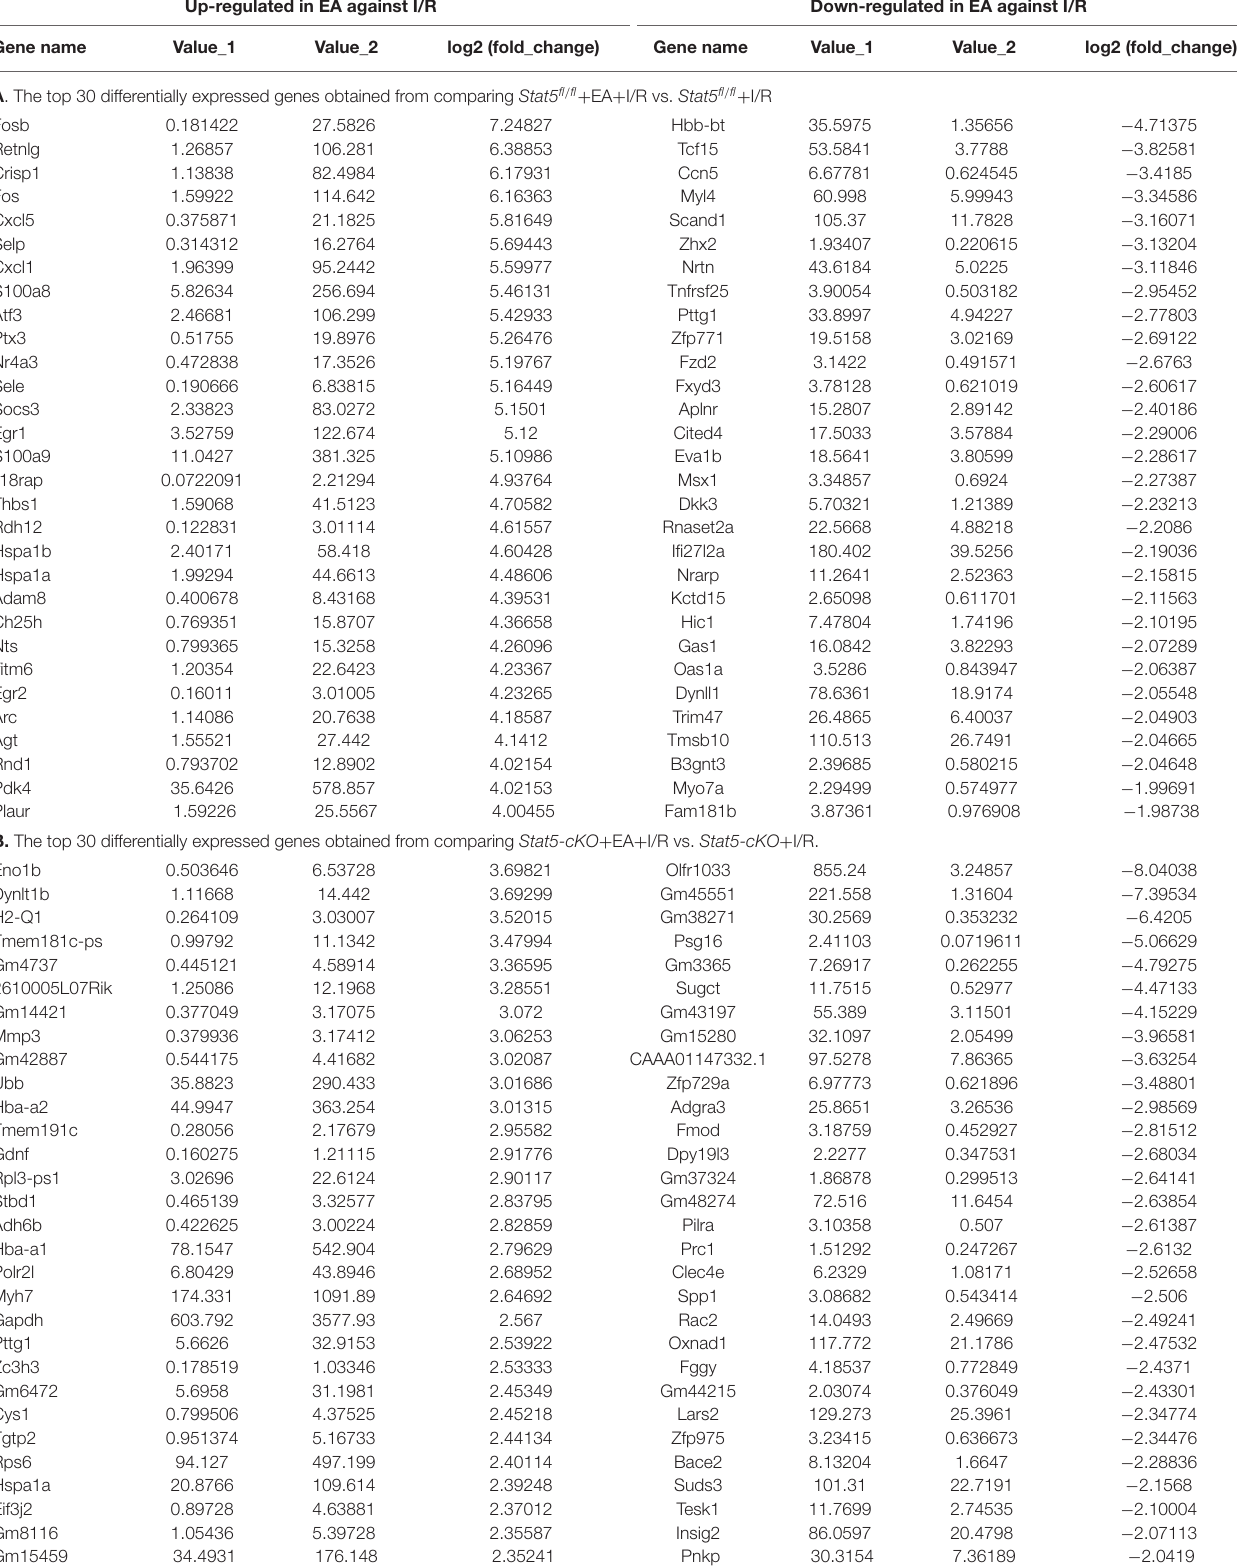
TABLE 1 | The top 30 differentially expressed genes with a log2 (FC) > | ± 1|and q < 0.05. Up-regulated in EA against I/R Down-regulated in EA against